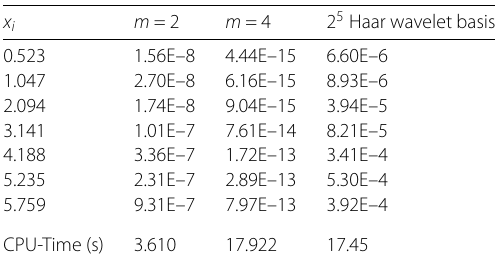
Figure 3 The plot of comparison between the exact and numerical solution for m = 4 of Example 5.2